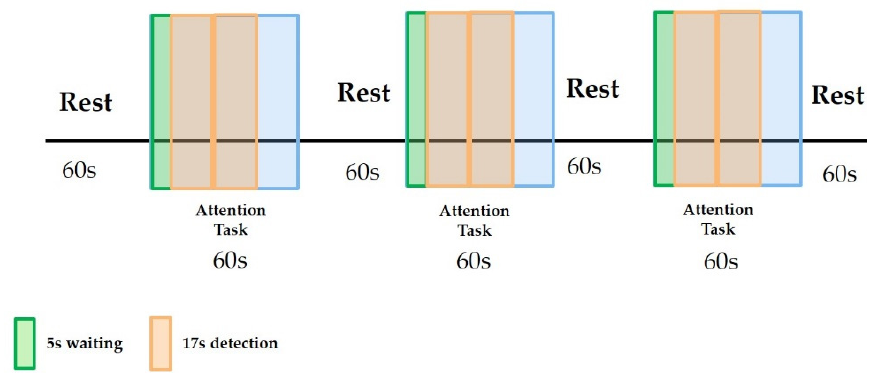
Figure 15. Illustration of the SCISCCO system detection time (orange blocks) relative to the attention test protocol. During each 60-s attention task, 2 data blocks were collected.